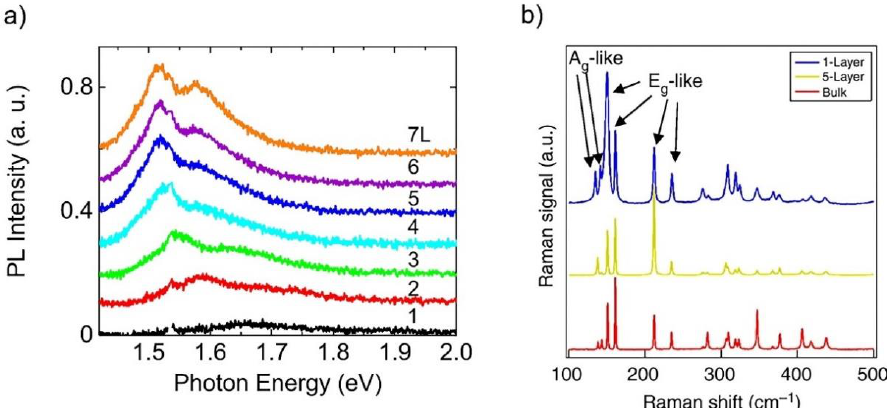
Figure 5. ( a ) Photoluminescence (PL) spectrum of ReS 2 flakes with different number of layers. Reprinted with permission from ref. [ 78 ] . Copyright 2018 Applied Physics Letters. ( b ) 18 Raman modes observed on monolayer, five-layer and bulk ReS 2 . Six labelled Raman modes include two low frequency Ag-like modes corresponding to the out-of-plane vibrations of Re atoms and four Eg-like modes corresponding to the in-plane vibrations of Re atoms. The rest 12 higher frequency Raman modes are vibrations mainly from lighter S atoms. Reprinted under the terms of a Creative Commons